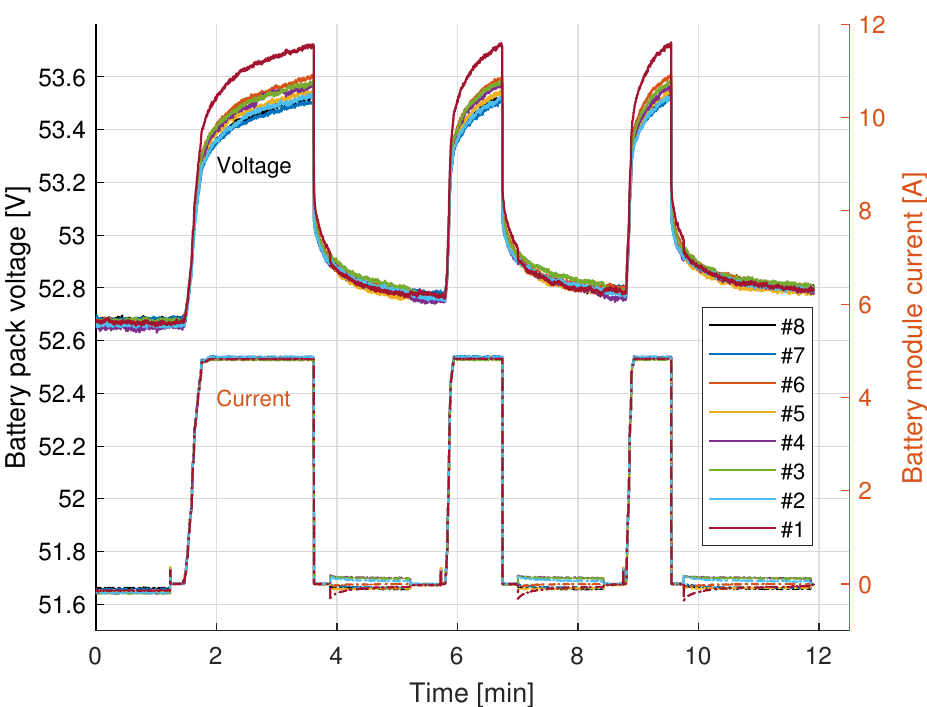
Figure 7. Battery module’s voltage and current during high-voltage series charging. Modules reaching top-charge show a faster voltage rise, equalized by intermittent rebalancing of modules by parallel connection. Again, module #1 reaches highest